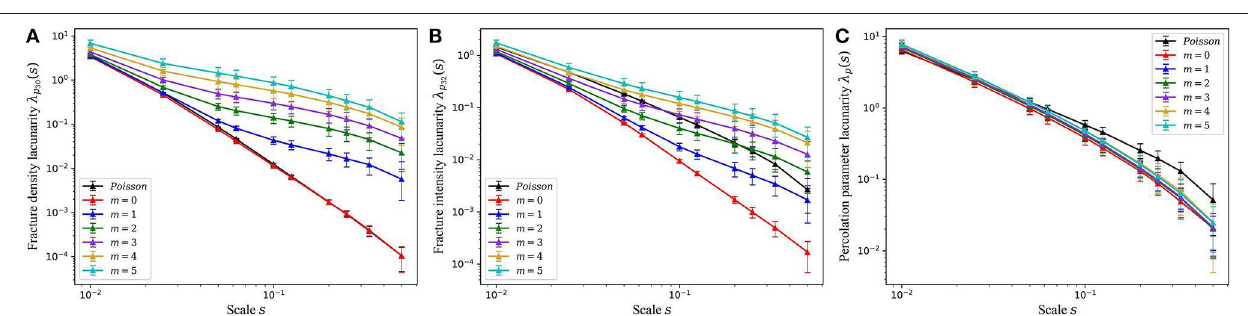
Frontiers in Physics |